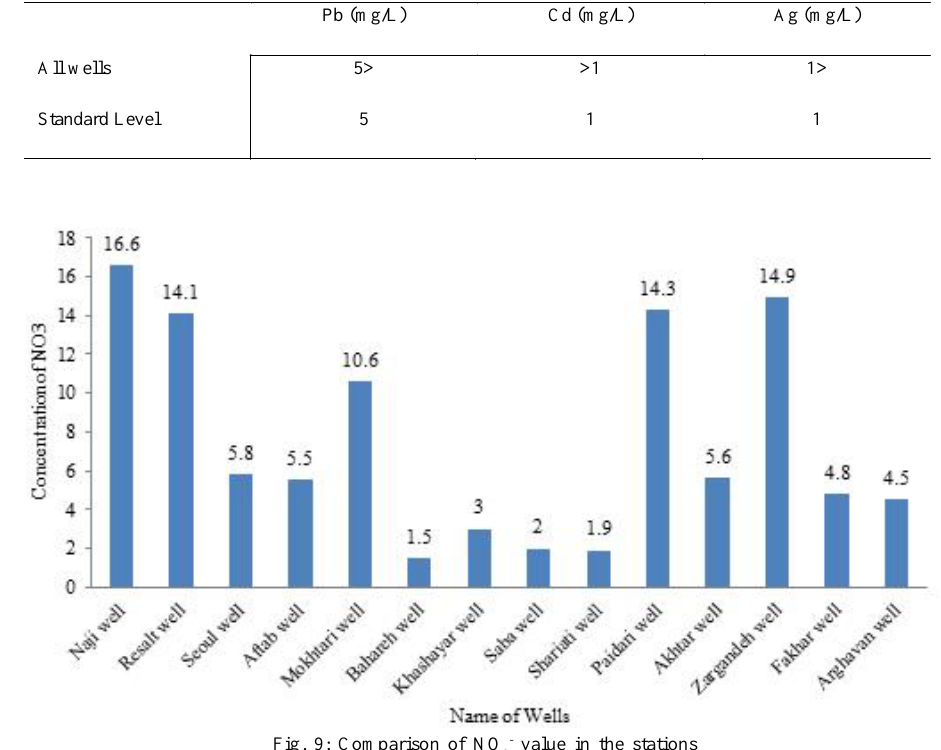
Fig. 9: Comparison of NO 3- value in the